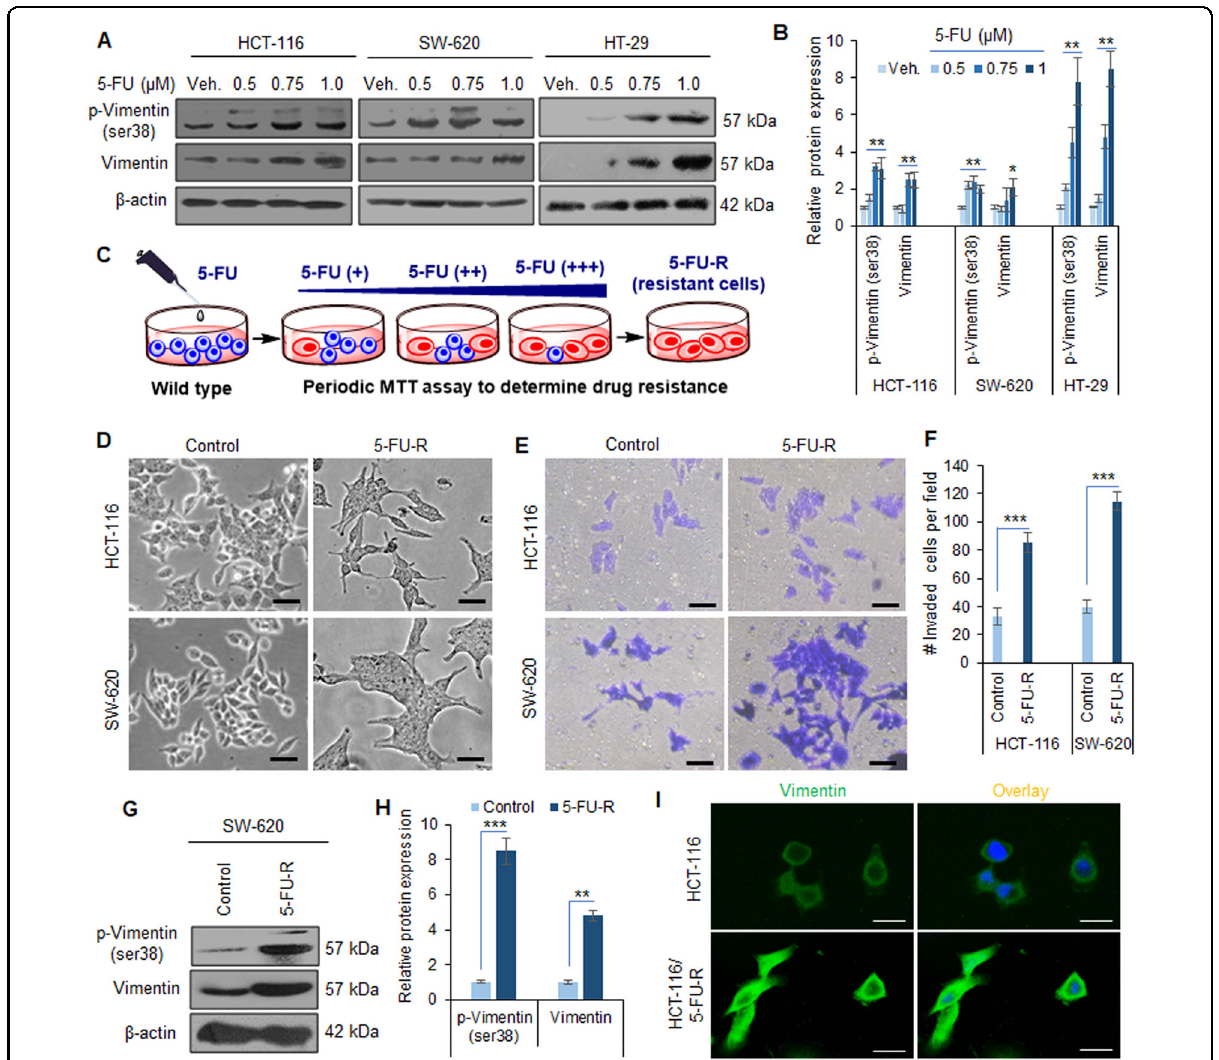
Fig. 1 Vimentin activation and the onset of EMT in CRC cells transiently exposed to 5-FU, as well as in 5-FU-resistant population. A Western blotting analysis depicting protein expression of p-Vimentin (Ser38) and Vimentin in HCT-116, SW-620, and HT-29 cells treated with indicated concentrations of 5-FU for 24 h. β -Actin expression was considered as an endogenous loading control. B Densitometry analysis of western blot bands presented above showing relative protein expression at each concentration of 5-FU. n = 3, error bars: mean ± SD; * P < 0.05, ** P < 0.01. C Model showing the procedure followed for generating the 5-FU-R cells from the wild-type CRC cells (details in “ Materials and methods ” ). D Phase contrast images showing the morphology of wild-type HCT-116 and SW-620 cells (control) versus 5-FU-resistant (HCT-116/5-FU-R, SW-620/5-FU-R) cells. Scale bar: 50 µm. E Matrigel invasion assay results showing the differences in invasion abilities of wild-type (control) versus 5-FU-R CRC cells. Scale bar: 50 µm. F Quanti fi cation of the number of invaded cells per fi eld from the above invasion assay experiment. n = 3, error bars: mean ± SD; *** P < 0.001. G Western blots depicting protein expression of p-Vimentin (Ser38) and Vimentin in wild-type (control) versus SW-620/5-FU-R cells. β -Actin expression was considered as an endogenous loading control. H Densitometry analysis showing the relative protein expression in each band of western blots presented above. n = 3, error bars: mean ± SD; ** P < 0.01, *** P < 0.001. I Immunocytochemistry results representing the Vimentin expression in wild-type (HCT-116) versus HCT-116/5-FU-R cells. Scale bars: 50